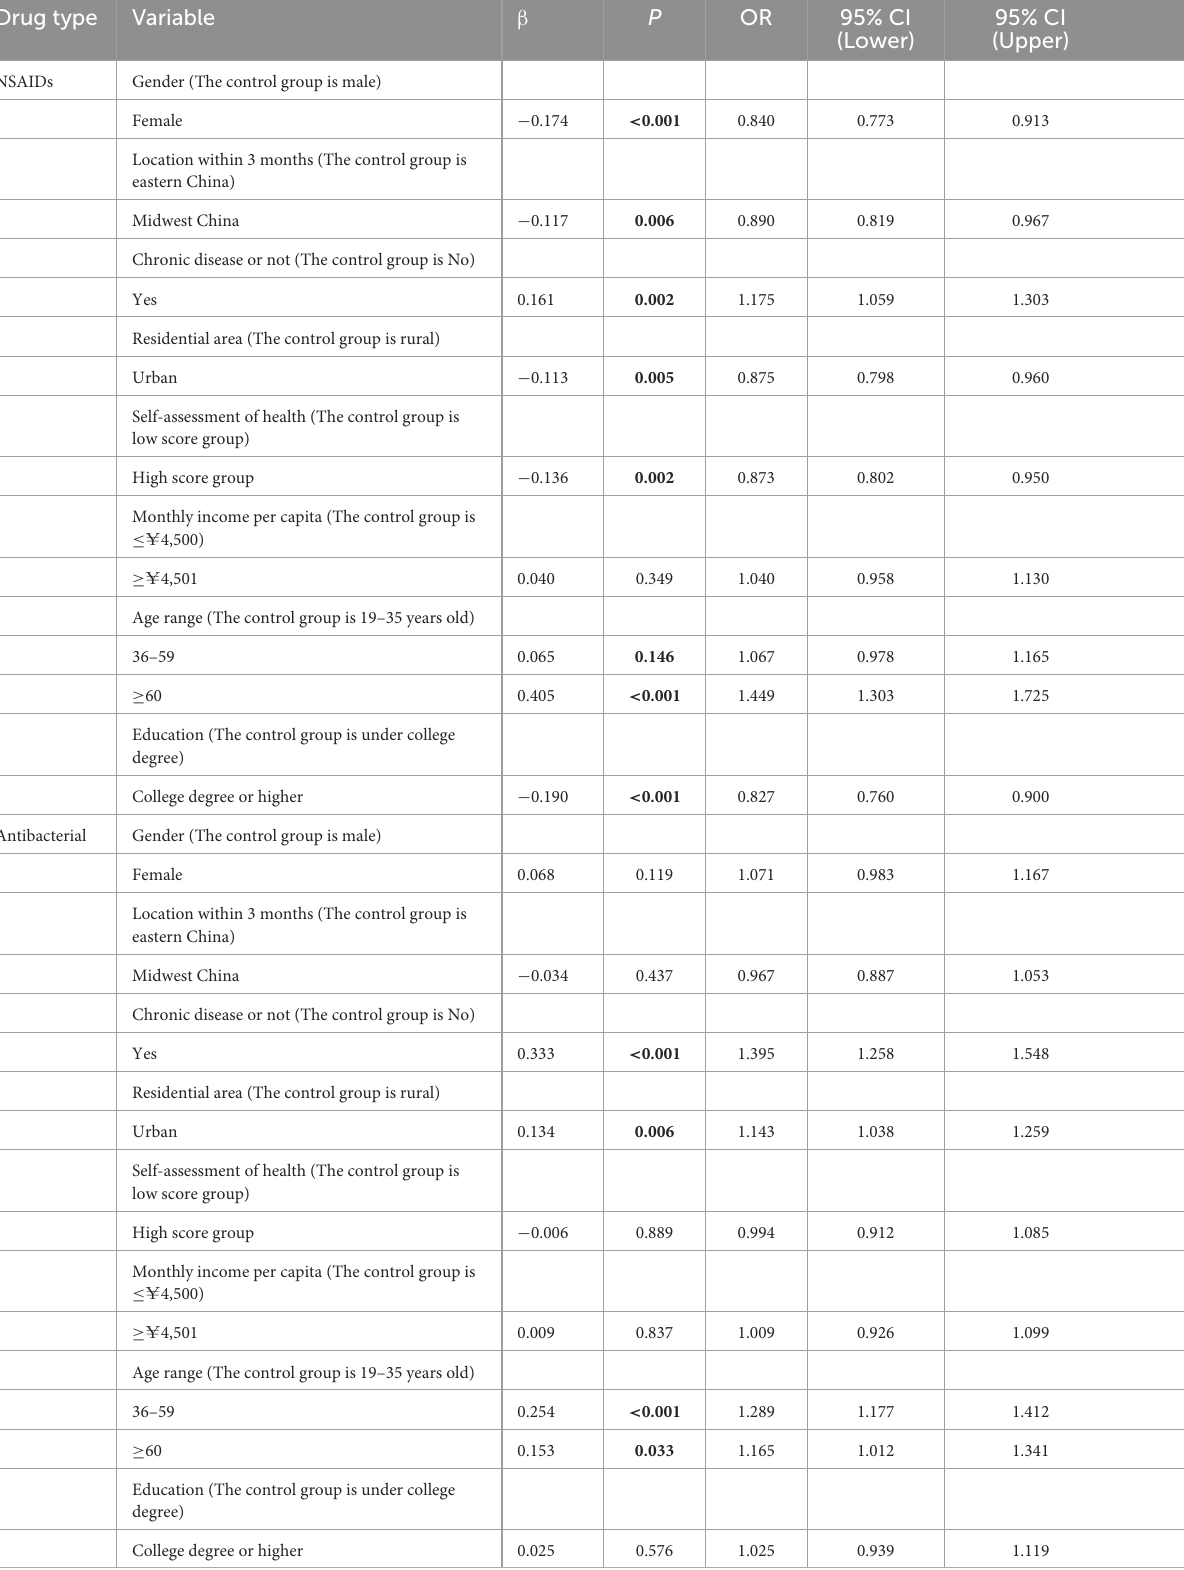
TABLE 3 One-way binary logistic regression analysis results of NSAIDs, antibacterial drugs, and social demographic characteristics. Drug type